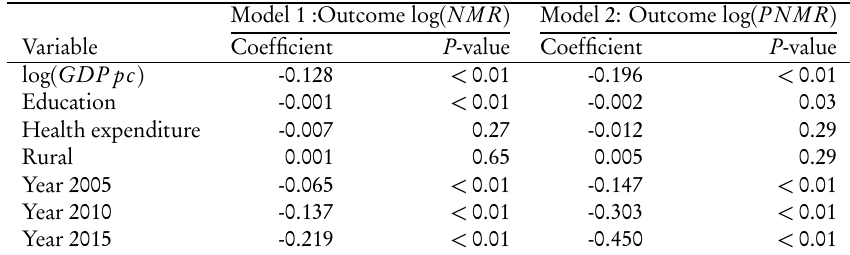
Fixed effect country-level regressions of the log neonatal and post-neonatal mortality rates; Models 1 and 2, Gini not